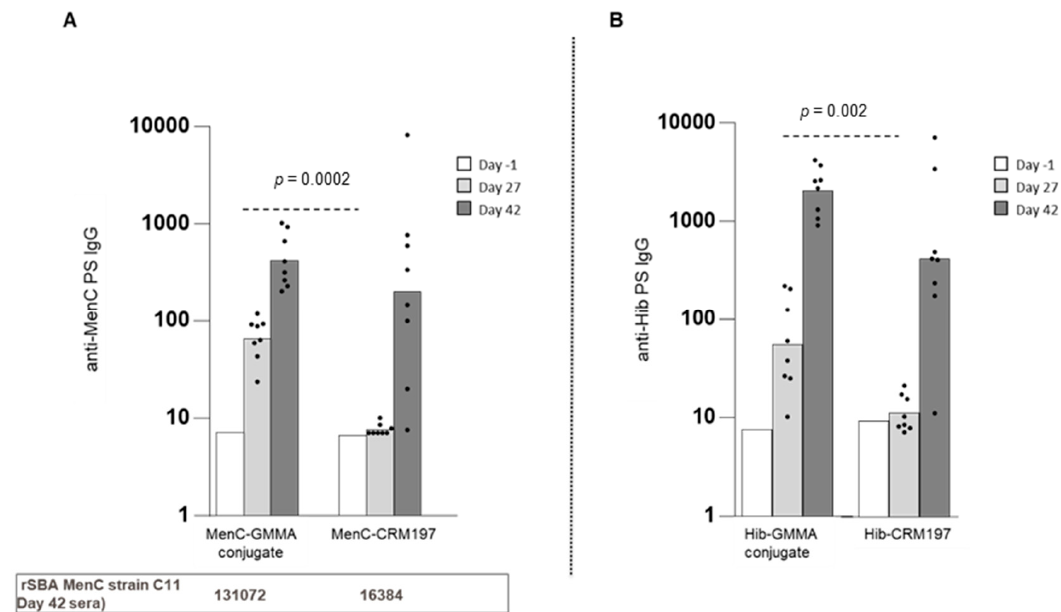
oligosaccharide per dose, in the presence of Alhydrogel. MenB GMMA alone and their physical mixture with Men oligosaccharides were used as controls. Sera were collected at days -1, 27, 42 and 197 and analyzed for anti-PS-specific IgG response ( A , B ). Summary graphs of anti-PS IgG geometric mean units (bars) and individual antibody levels (dots) are reported. Anti-PS IgG were analyzed using a two-tailed nonparametric Mann–Whitney test . p -values (rounded to the nearest larger number) less than 0.05 were considered statistically significant. SBA titers of pooled sera collected 2 weeks and 6 months after second injection against MenA ( C ) or MenC ( D ) strains are reported.